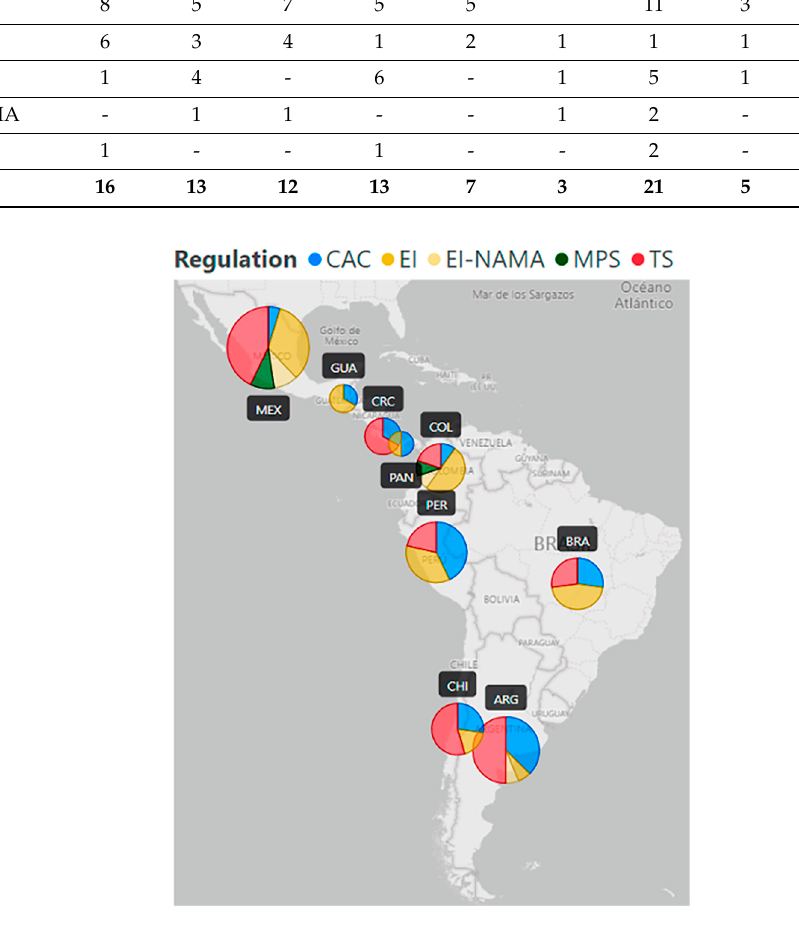
Figure 4. Geographical distribution of the green building rule (GBR) rule types in our review. The size of each bubble is proportional to the number of GBRs enacted to date and the colours show the distribution of individual policy types in each country.